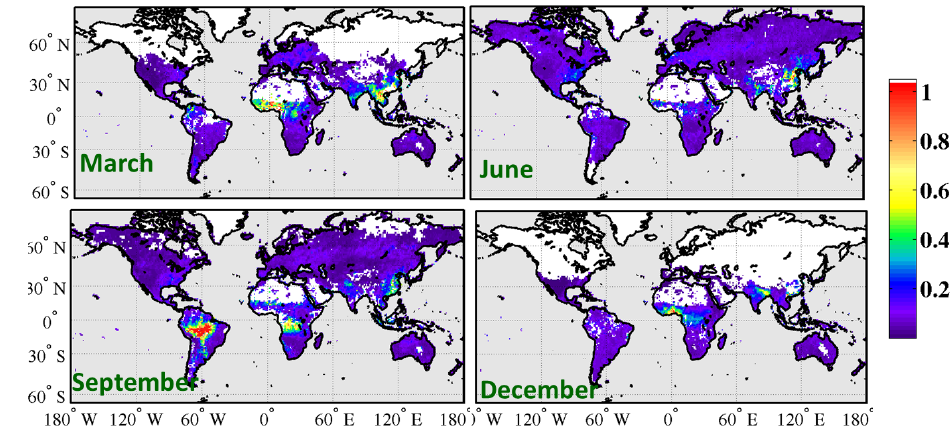
Figure 1. Monthly aggregated AOD at 555nm retrieved with ADV for March, June, September and December 2007.